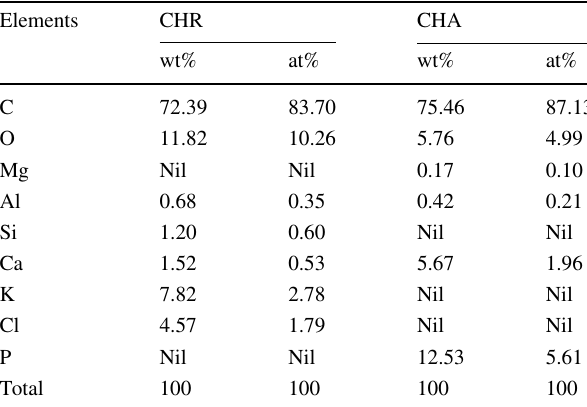
Table 3 Elemental analysis from EDX spectra of CHR and CHA Elements